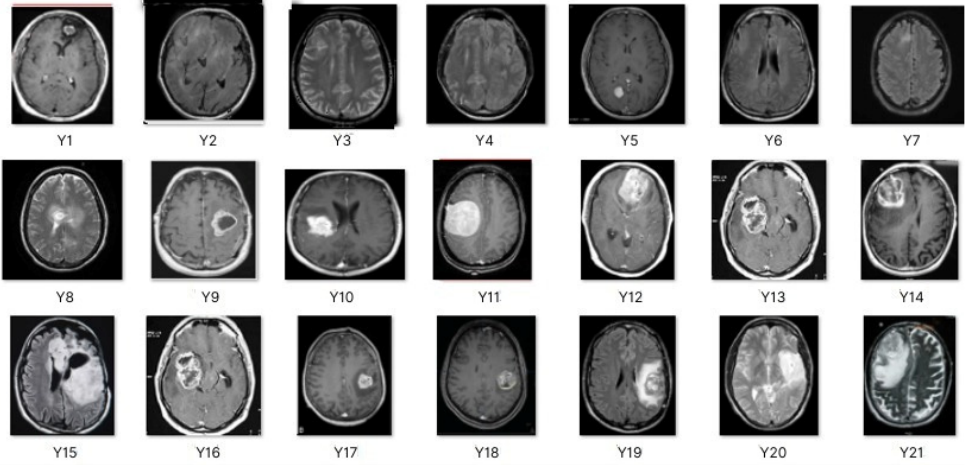
Figure 2. MRI samples Normal Brain MRI (Y1 to Y8) Benign tumor MRI (Y9 to Y15) Malignant tumor MRI (Y16 to Y21).